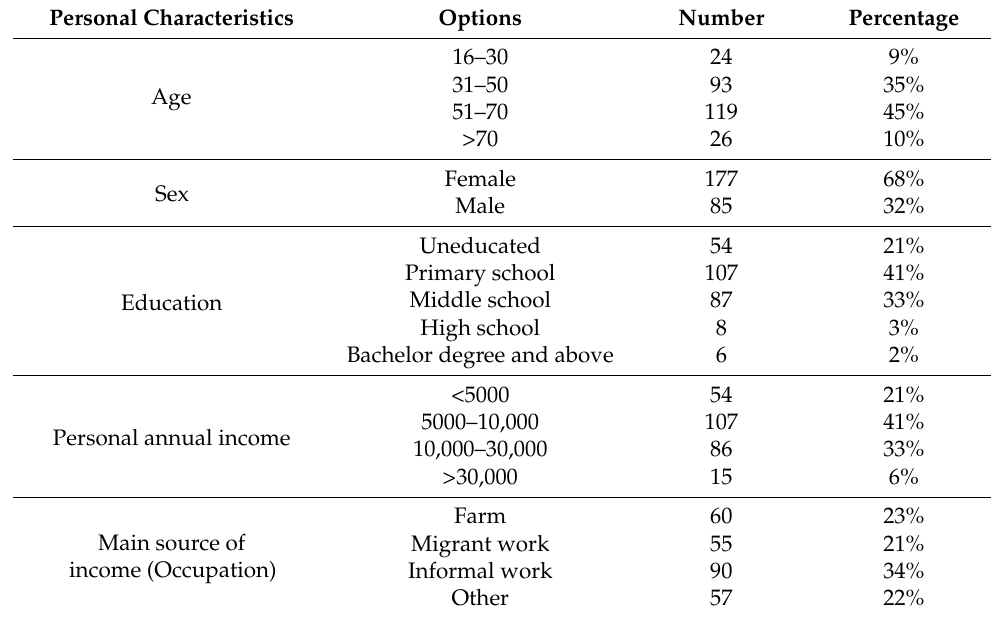
Table 1. Personal characteristics of